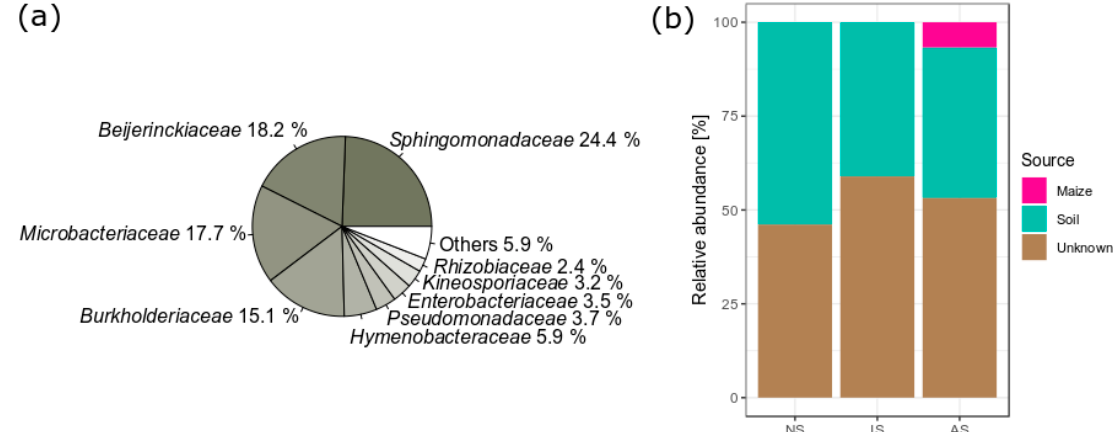
Figure 6. ( a ) Mean relative abundance of bacterial families in natural maize litter prior to soil application ( n = 3). “Others” denotes bacterial families with less than 2% relative abundance. ( b ) The proportion of amplicon sequence variants (ASVs) in soil bacterial communities on week 6, which are estimated to come from different source environments using SourceTracker ( n = 3). Maize and soil samples (NS: natural soil, IS: inoculated soil, and AS: autoclaved soil) on week 0 were considered to be source samples, while soils on week 6 were considered to be sink samples. ASVs that did not match a specific source environment were marked “Unknown”.